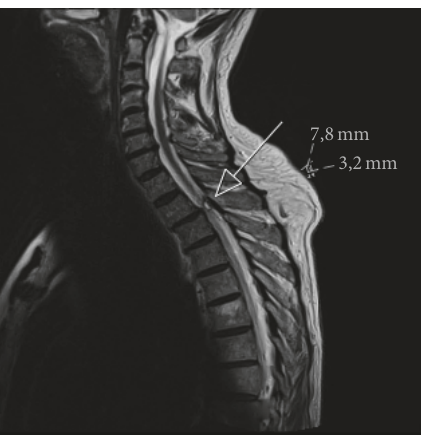
Figure 1: MRI of the upper spinal column T2-weighted sequence, sagittal plane. White arrow showing a 7,8 mm by 3,2 mm cyst at the Th2-3 level on the right side.